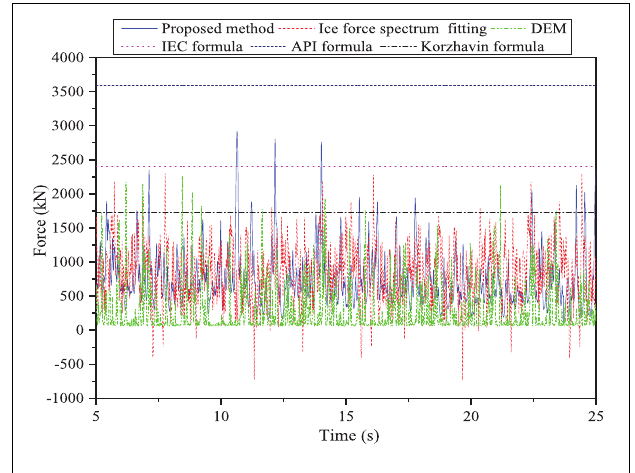
FIGURE 7 | Ice force time history. FIGURE 8 | Three directions of displacement at the collision area of the